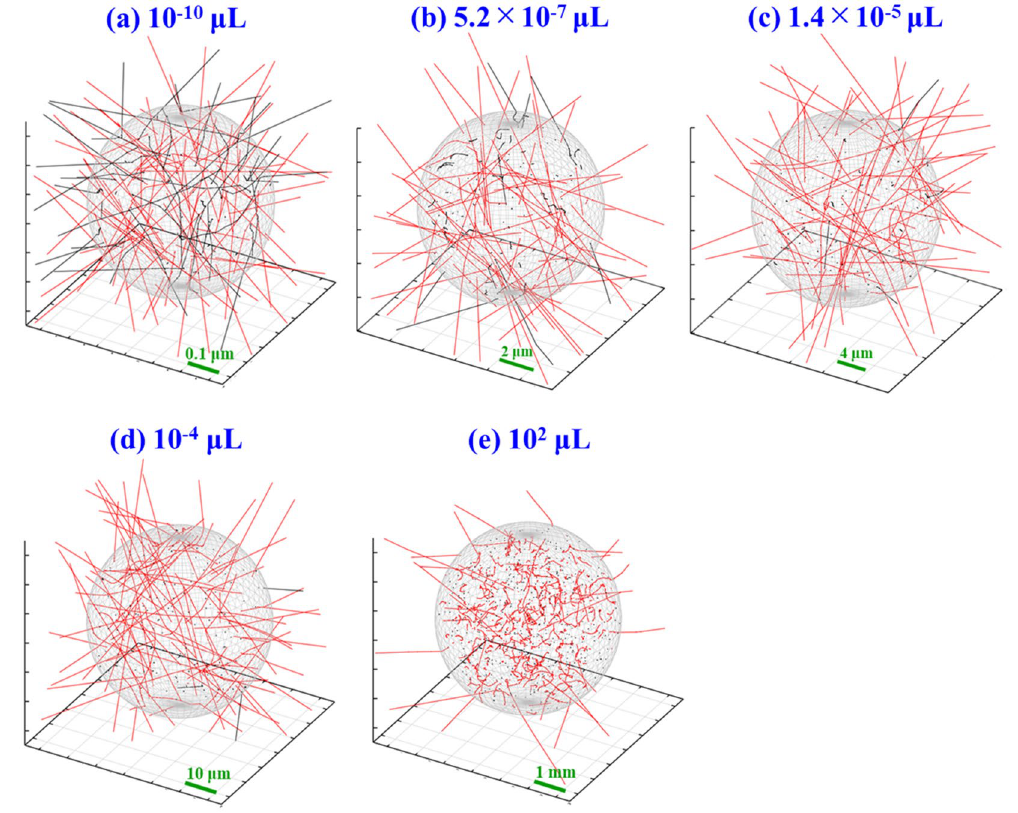
Figure 2. Simulated trajectories of Auger electrons (black) and beta particles (red) in water spheres with ( a ) 10 –10 , ( b ) 5.2 × 10 –7 ( c ) 1.4 × 10 –5 ( d ) 10 –4 and ( e )10 2 μL. The trajectories of secondary particles were not described. The sizes of spheres with 5.2 × 10 –7 and 1.4 × 10 –5 μL are concordant with radii of 5 and 15 μm, respectively, and correspond to the size of cell nucleus and